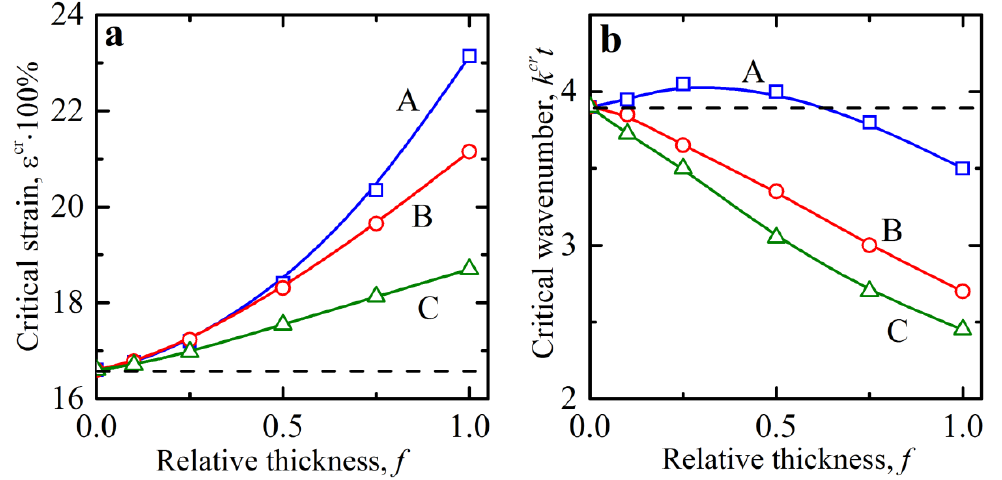
Figure 6. Critical strains ( a ) and wavenumbers ( b ) in the dilute composites with interphasial layers. The volume fraction is 𝑣 𝑙 = 0.025 . Horizontal dashed black line corresponds to the case of ideal composites.